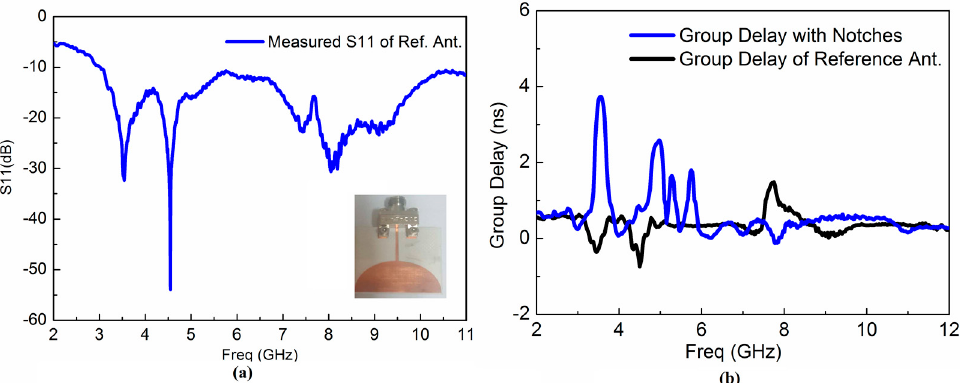
Figure 9. ( a ) Measured S11 response of the reference UWB antenna ( b ) Group Delay of the reference vs. proposed multiple notched UWB antenna.